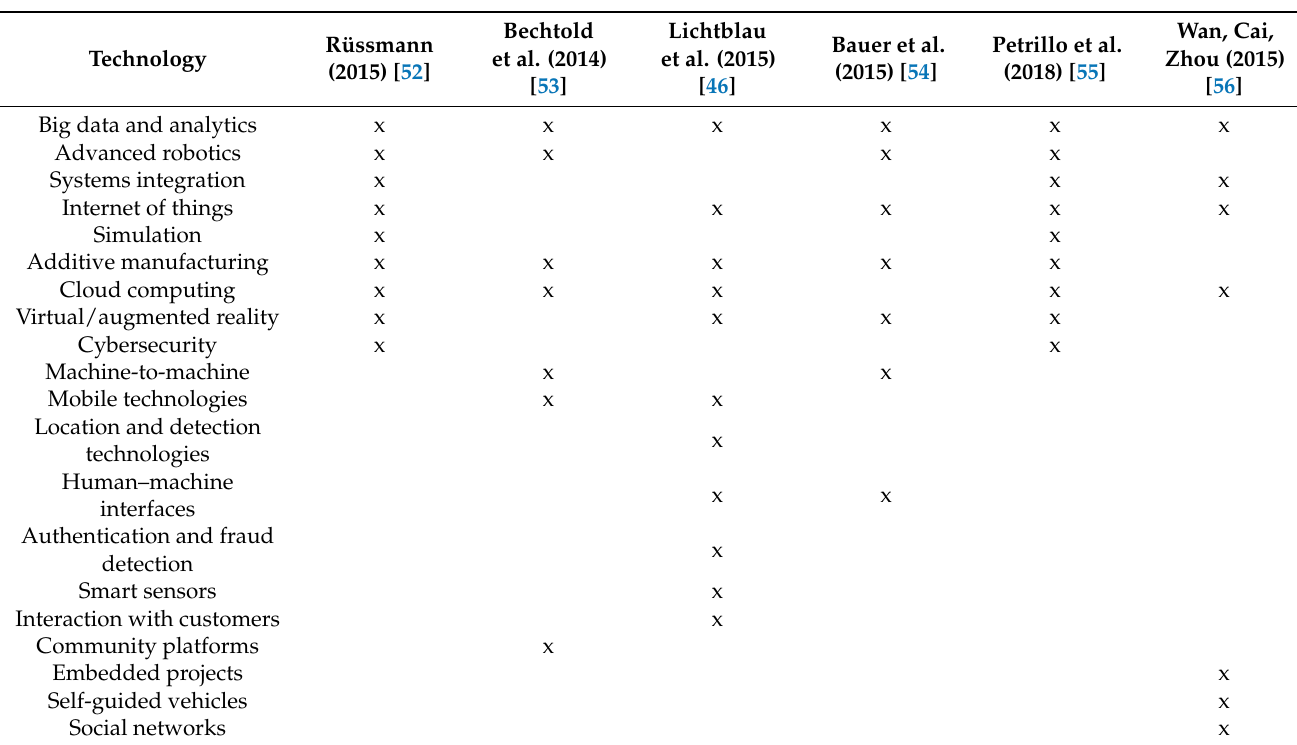
Table 1. Key enabling technologies for Industry 4.0 and/or the Fourth Industrial Revolution, accord- ing to different